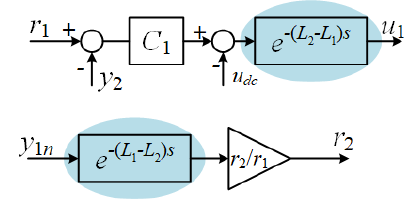
Figure 8. Dead-time difference compensation.